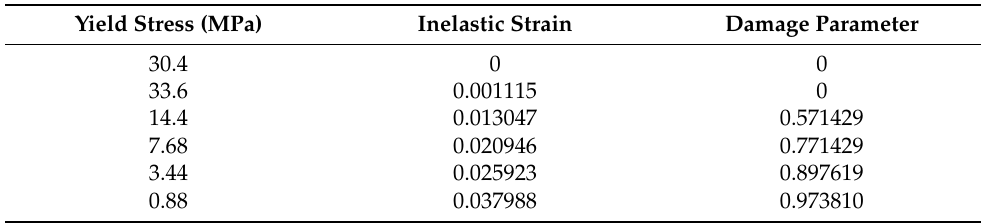
Table 3. Compressive input parameters of REF.